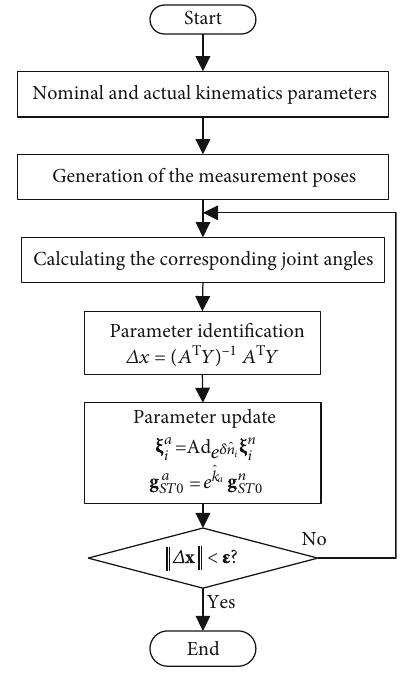
Figure 13: Flowchart of the on-orbit kinematics